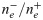
AUPR scores of the NN-MT and RN-MT multi-task methods as a function of the ne-/ne+ ratio, for a number of extra-task positive pairs ne+ varying from 1 to 50.(a): NN-MT, θ = 0.20. (b): NN-MT, θ = 0.80. (c): RN-MT, θ = 0.20. (d): RN-MT, θ = 0.80. The two methods are trained with intra-task and extra-task examples that are both dissimilar to the tested pair (percentile-based similarity thresholds θ of 20 and 80). Exact values can be found in Supporting Information respectively in S14–S17 Tables.